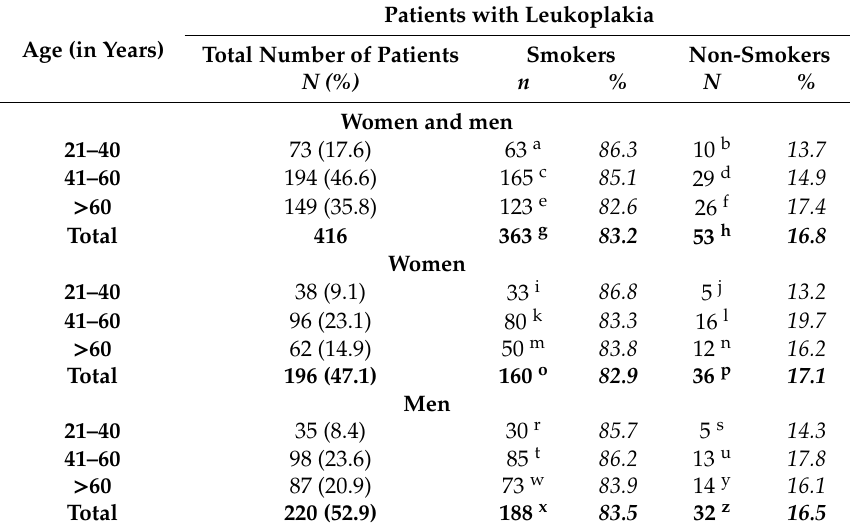
Table 1. Number and percentage of patients diagnosed with leukoplakia smokers and non-smokers by gender and age. Patients with Leukoplakia Age (in Years) Total Number of